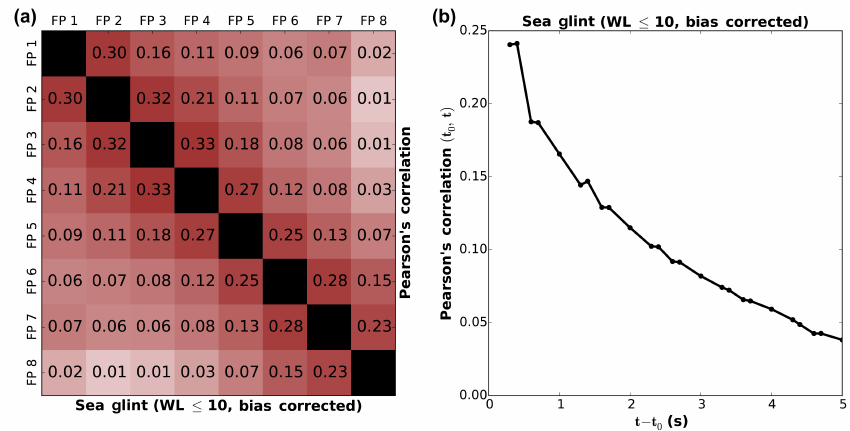
Figure 5. (a) Correlation of differences across pixels between observed minus mean within a neighborhood. (b) Correlation between obser- vations for a single